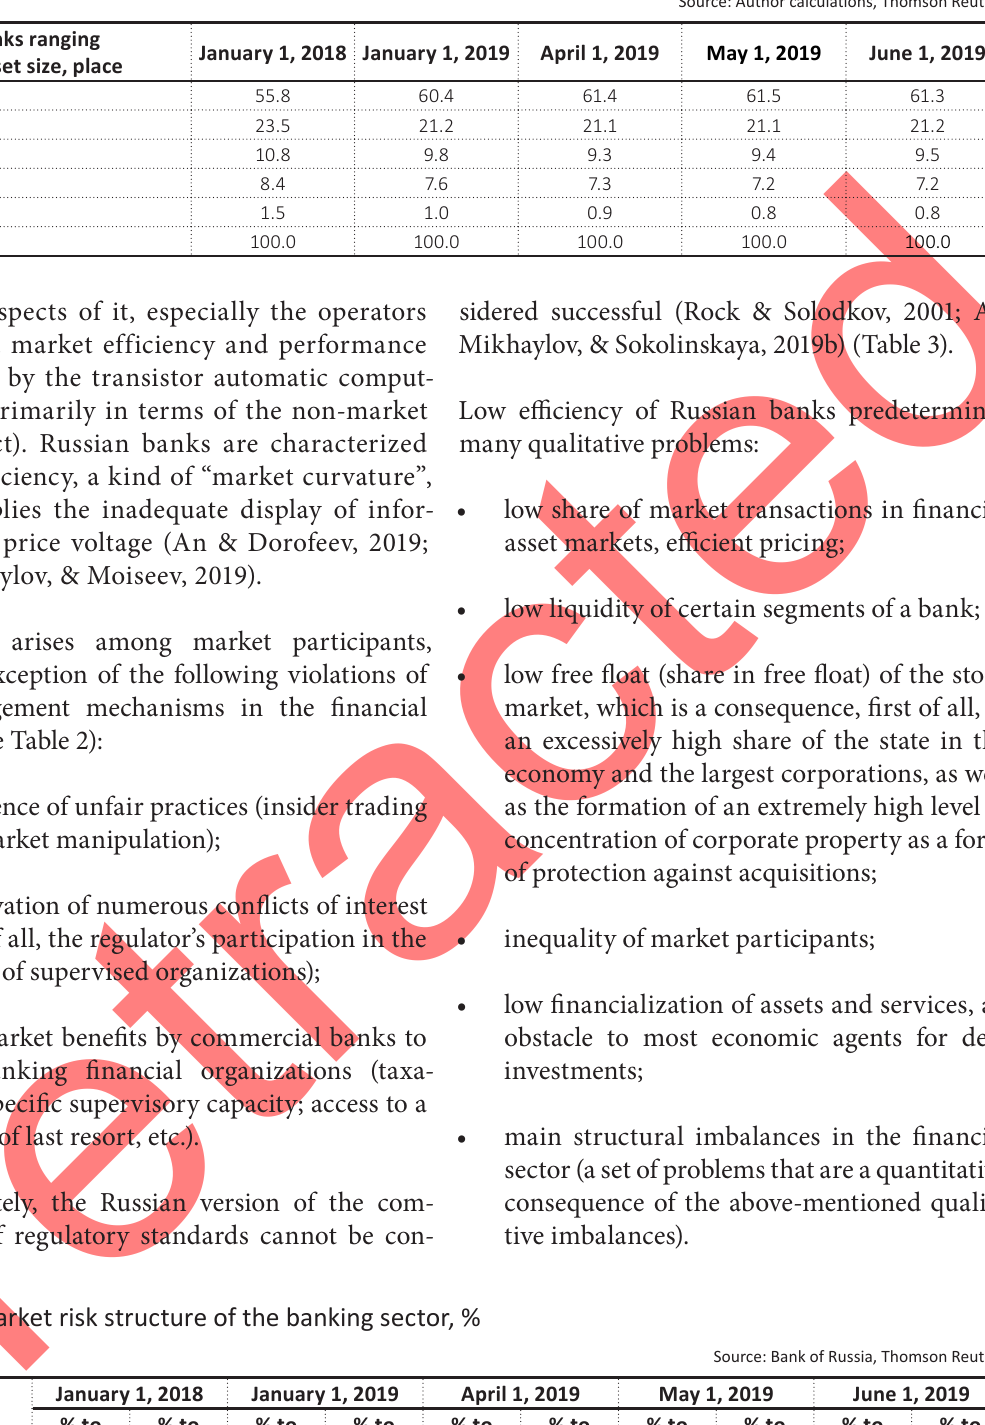
Source: Bank of Russia, Thomson